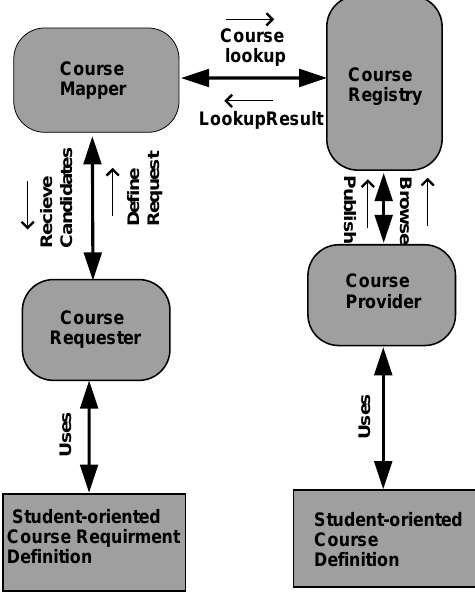
Figure 2. Extended SOA